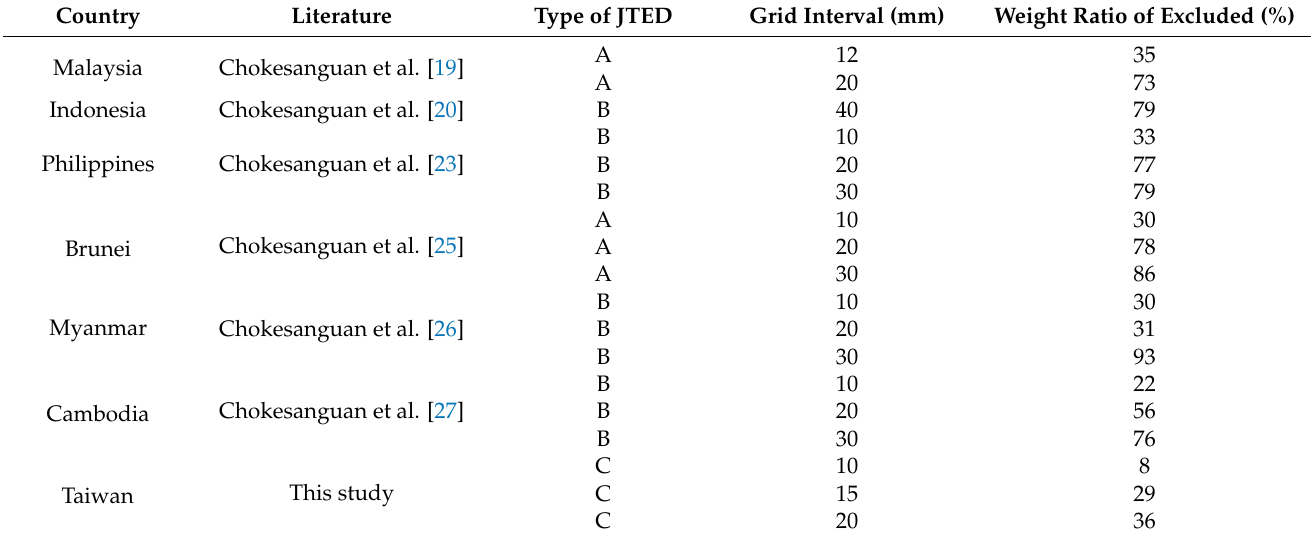
Table 4. Total catch excluded by JTEDs of this study and previous studies by